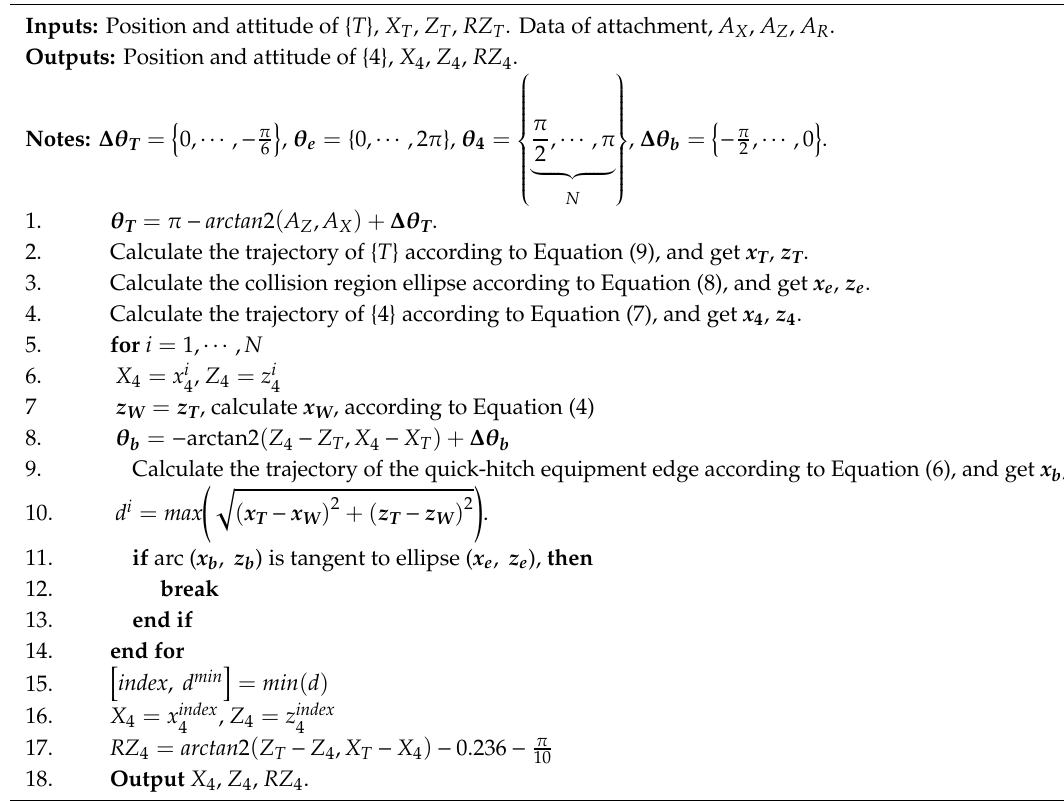
Algorithm 1 Calculate the optimal joint position of joint